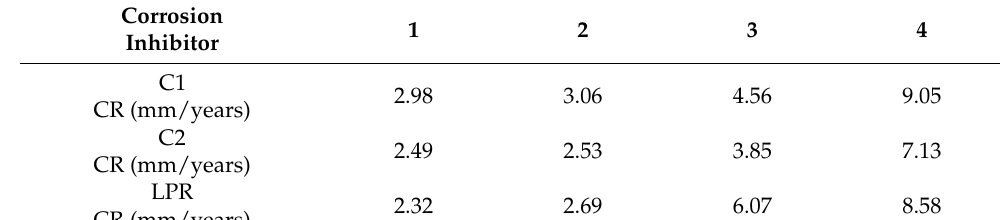
Table 3. Measurements of corrosion rate relative to weight loss and LPR.